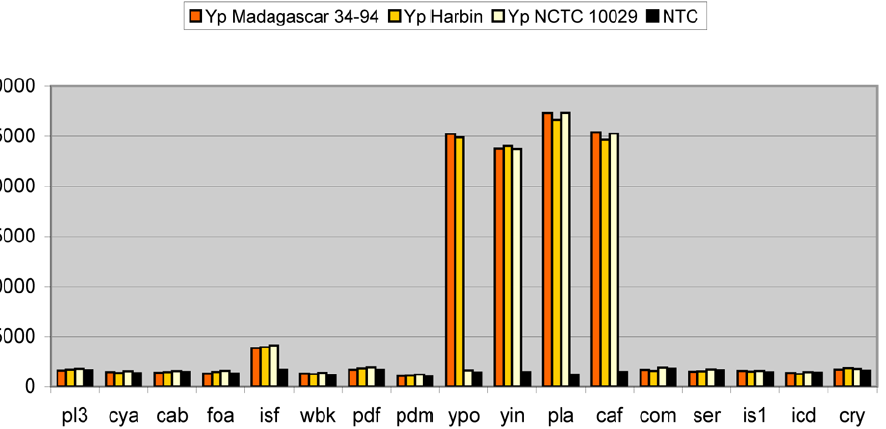
Figure 2. DH suspension microarray measurement showing minor cross-reactivity. Three Y. pestis strains (Yp) and the no template control (NTC) are shown from a DH measurement. Probe isf showed a minor signal when a high load of Y. pestis genomic DNA was amplified.